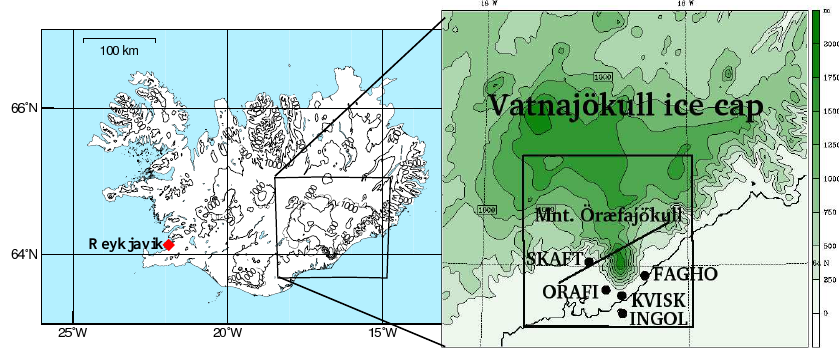
Figure 2: The 1 km domain setup of the Vatnajökull ice cap and location of observational sites. The box on the right hand side shows the region of interest around Mt. Öræfajökull (cf. Fig. 4). The location of the Freysnes hotel coincides with location SKAFT. The colour scale to the right represents the terrain height.